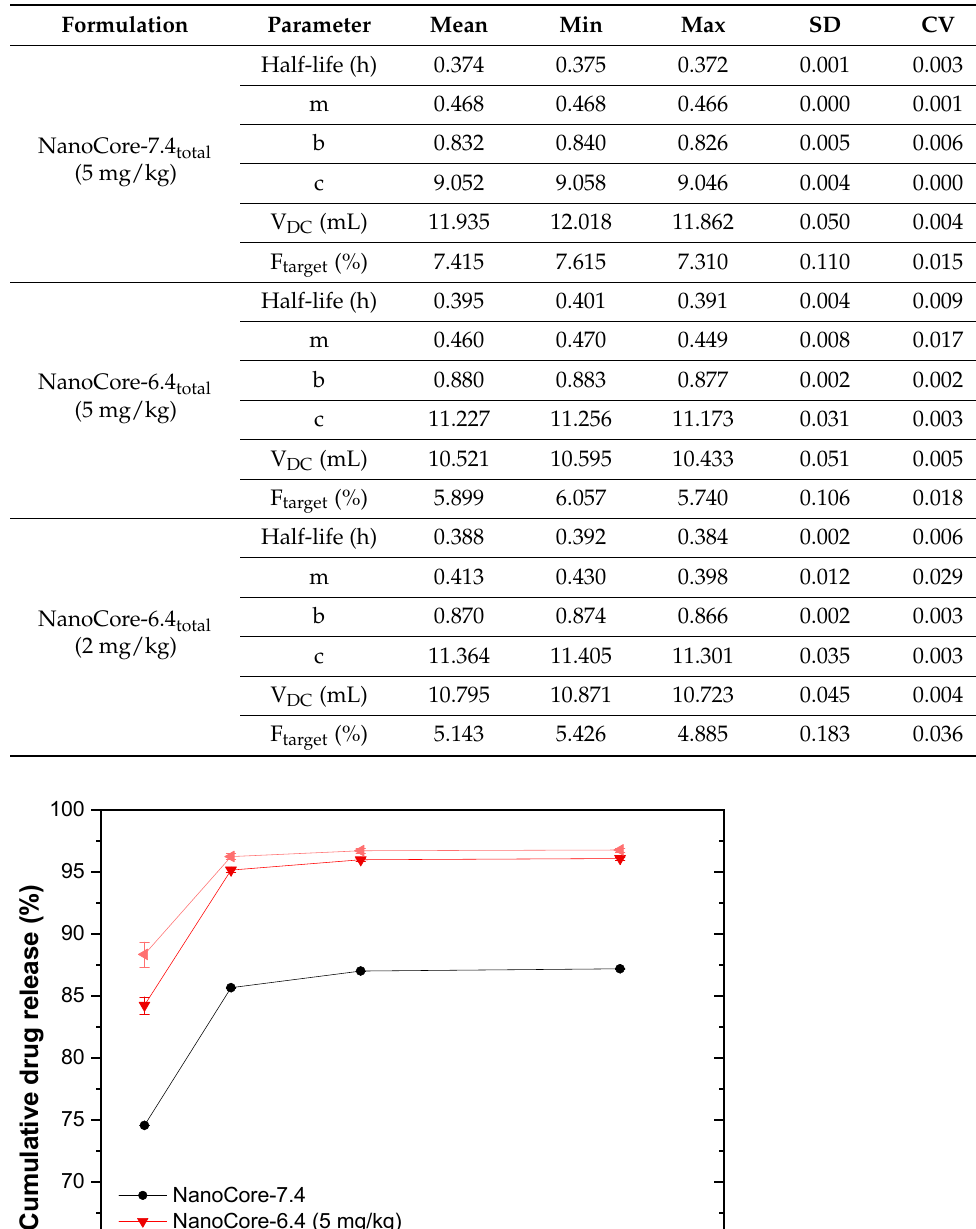
Table 5. Pharmacokinetic parameters identified by the PBNB model using a more restrictive range for the carrier half-life.